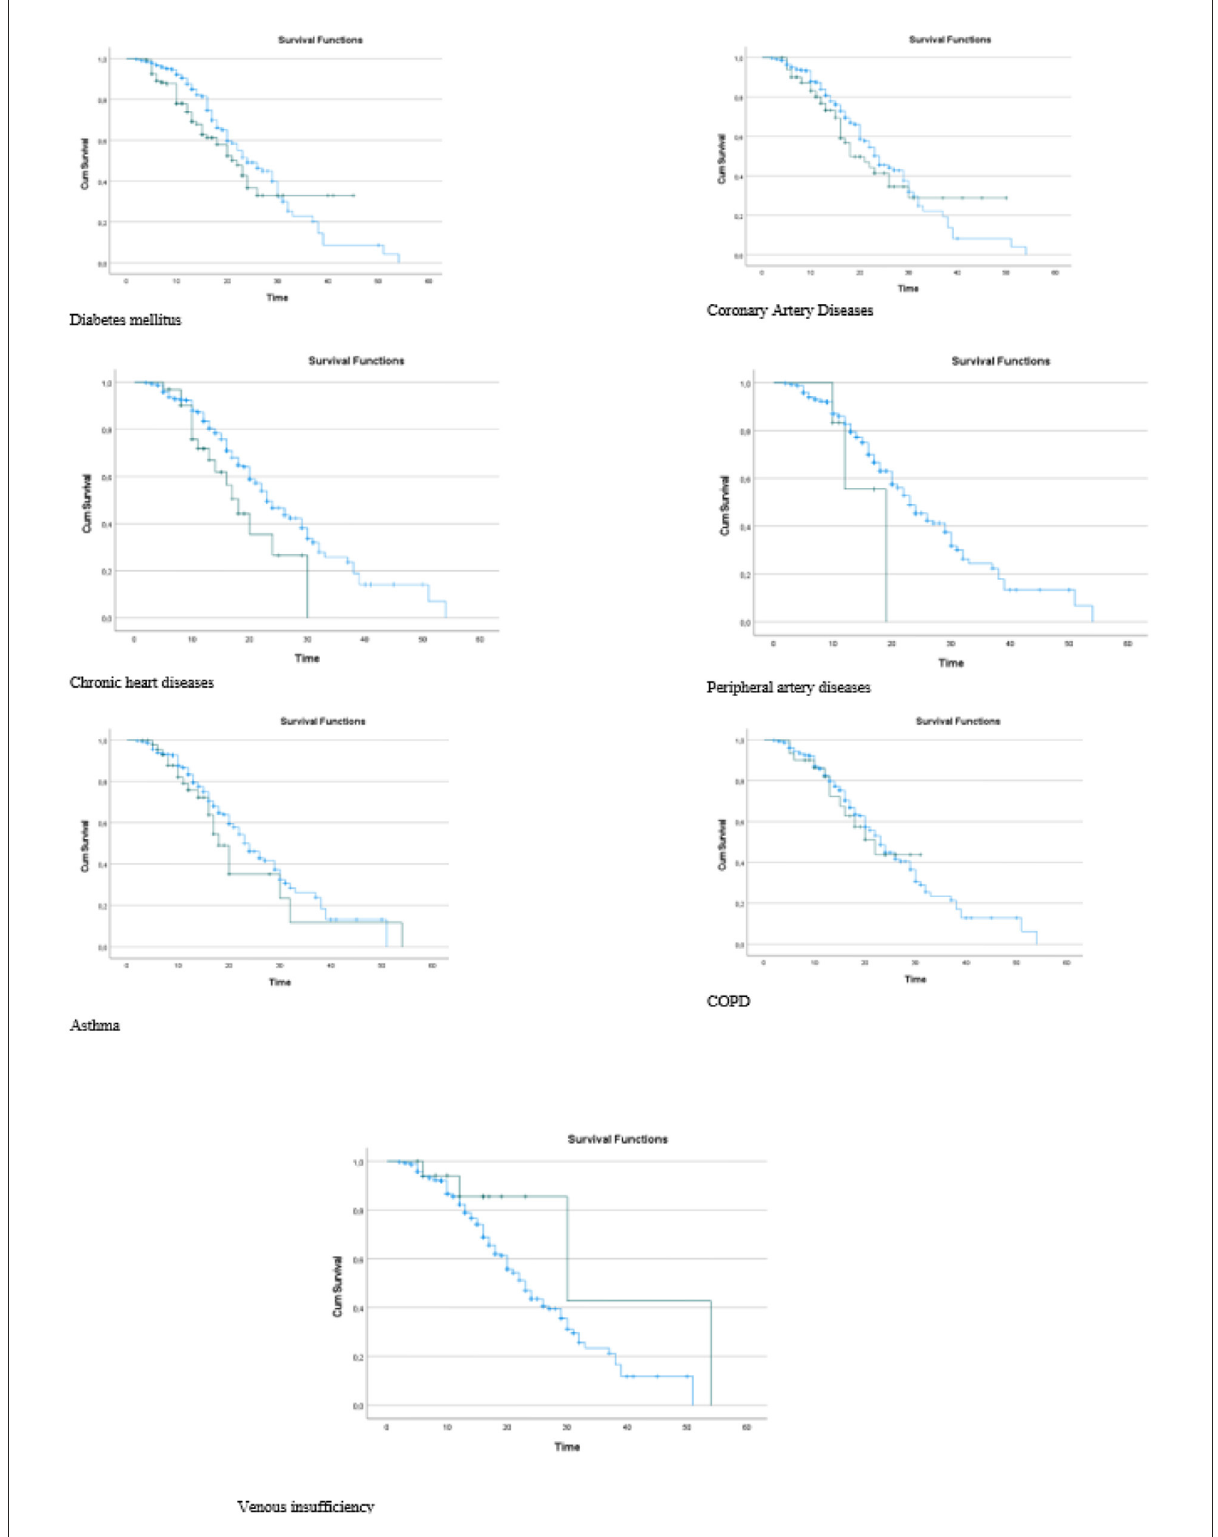
FIGURE3 Kaplan Meier curves stratified by